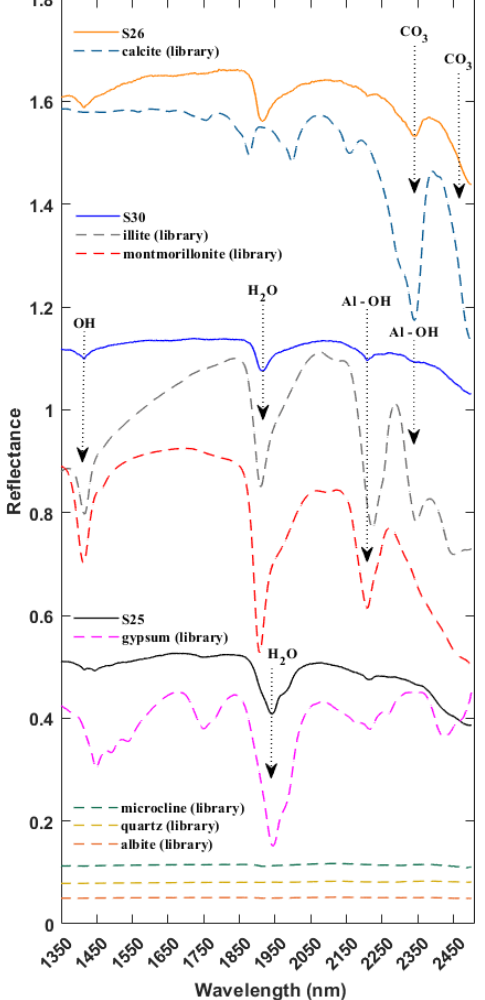
Figure 3. SWIR spectra for three representative samples (S25, S26, S30) and library spectra of pure minerals showing diagnostic fea- tures for calcite, montmorillonite, illite, and gypsum. All spectra are offset for clarity. Arrows near 1400, 1900, 2200, and 2345nm call out features arising from OH, water, and Al–OH in mineral struc- tures, common to many clay minerals such as montmorillonite and illite. Arrows targeting 2340 and 2480nm show the wavelengths of dominant absorption features in calcite. The arrow at 1945nm rep- resents the unique spectral signature attributed to water in sulfates such as